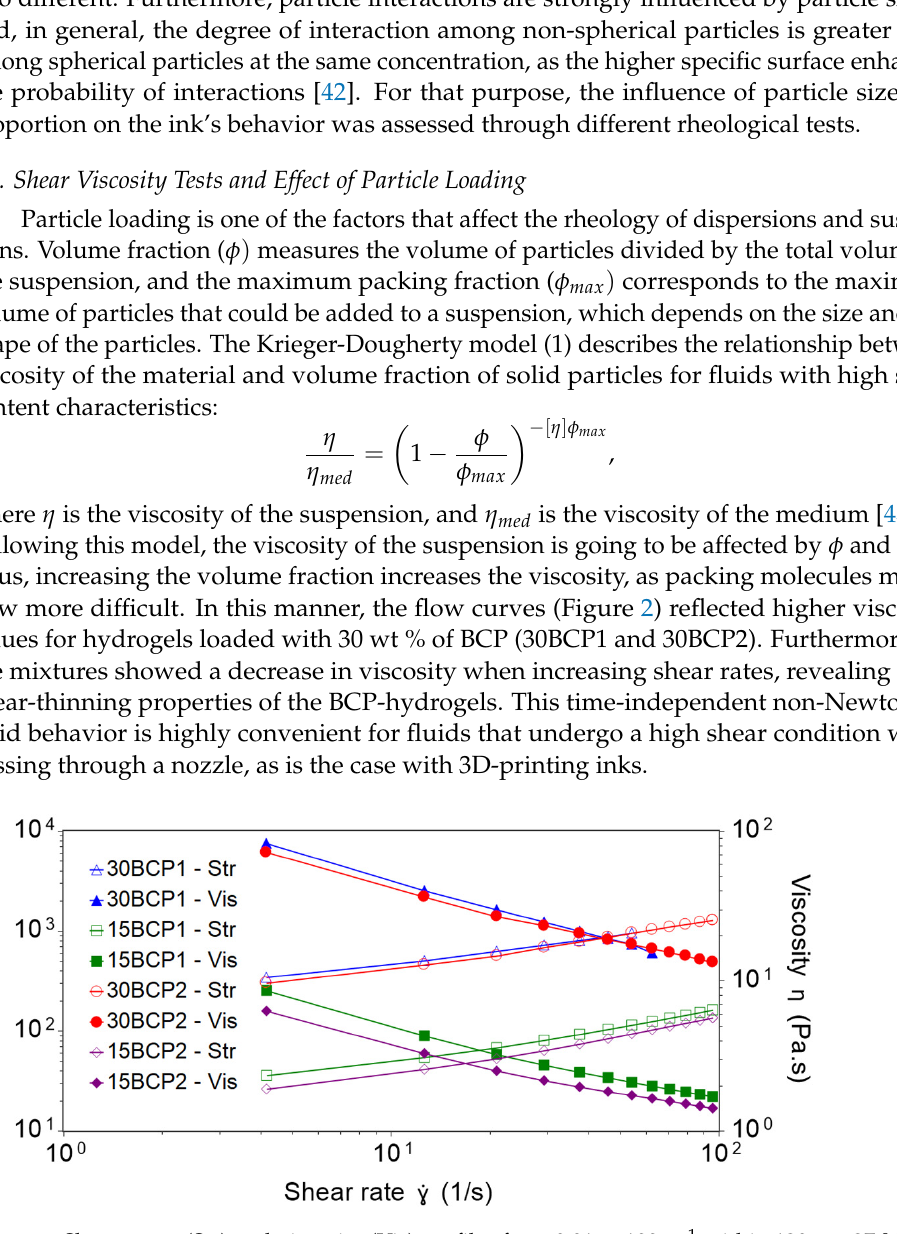
Figure 2. Shear stress (Str) and viscosity (Vis) profiles from 0.01 to 100 s − 1 within 120 s at 37 °C.